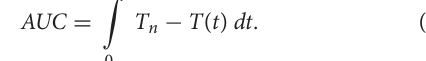
FIGURE 3 | Group-specific estimates of parameters k and p 0 . Estimation of the parameters k (Equation 5) with s = 3. Data are presented as mean ( ± 95 % confidence intervals). Statistical analysis was performed using two-sided, pairwise t -tests. All p -values are adjusted for multiple testing using the Benjamini-Hochberg algorithm. Only the 6 significant differences for k (0 < ∗∗∗ ≤ 0.001 ≤ ∗∗ ≤ 0.01 ≤ ∗ ≤ 0.05) and the 4 non-significant differences for p 0 are